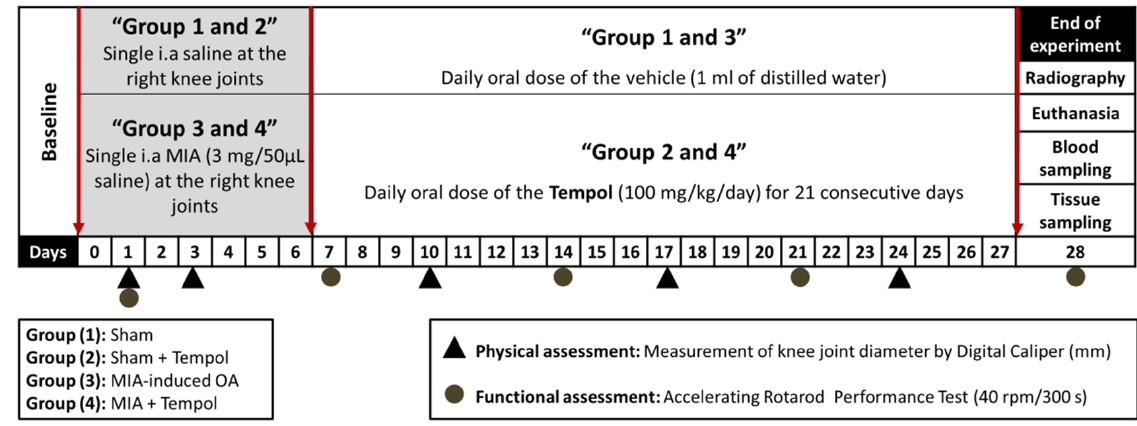
Figure 10. Schematic diagram of the experimental protocol.